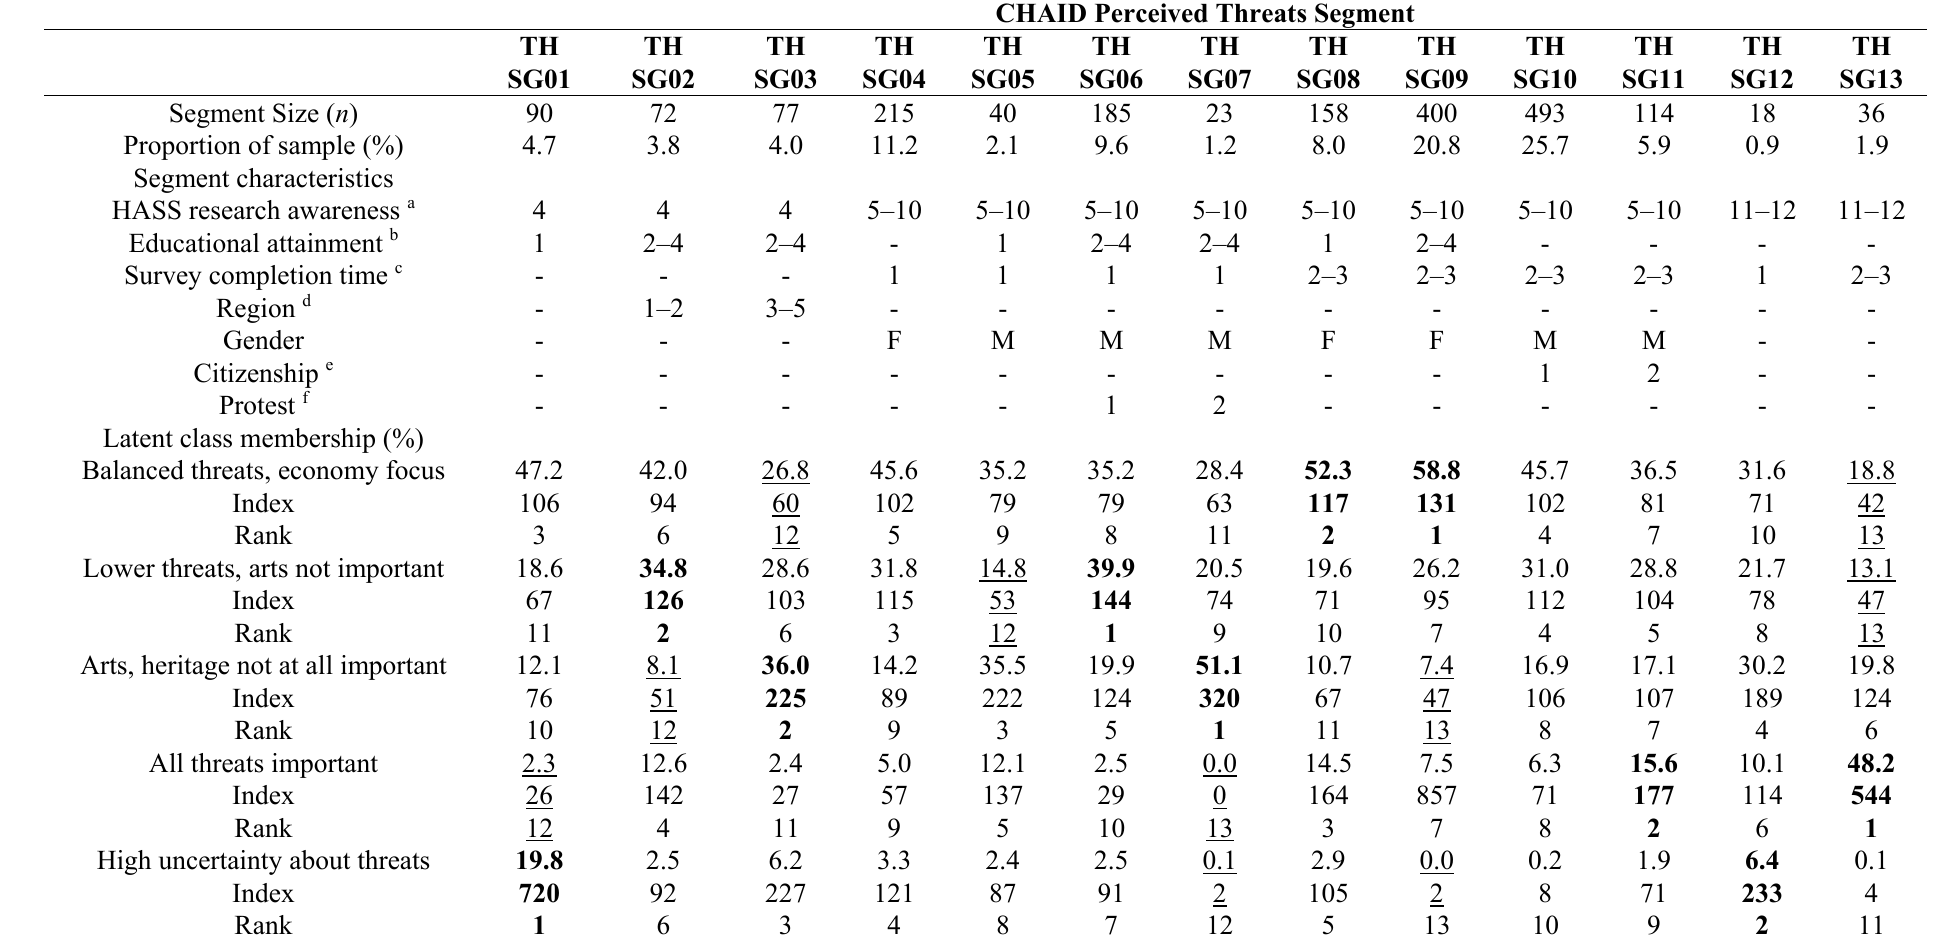
Table 4. Summary of segmentation of threat-based latent class